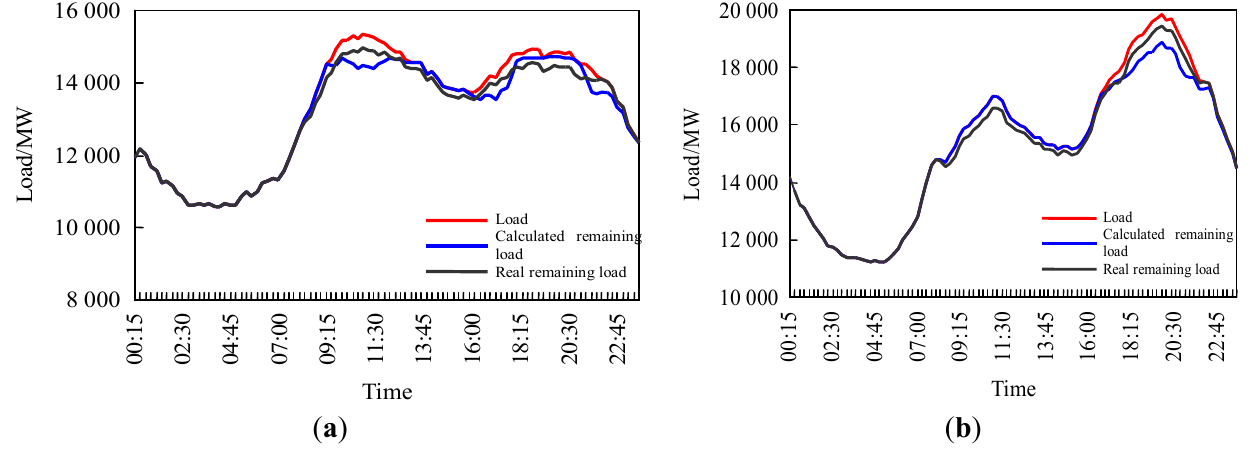
Figure 9. Comparison between the optimal results of Scheme 1 and real values; ( a ) SHPG; and ( b ) ZJPG.